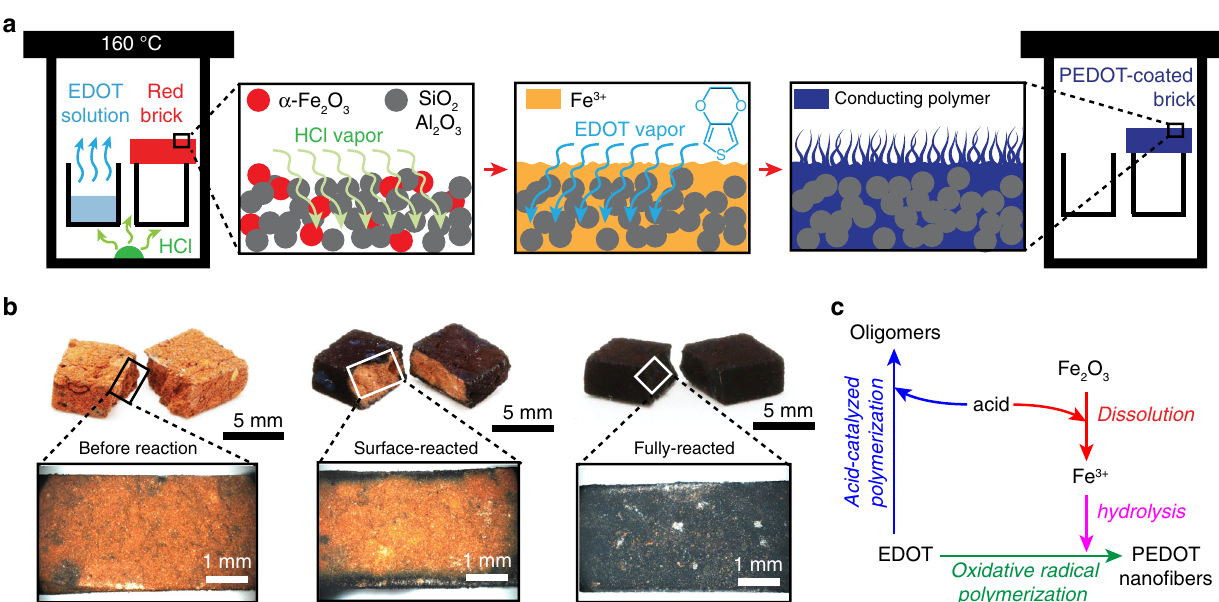
Fig. 1 Deposition of a nano fi brillar PEDOT coating on brick. a In a one-step reaction, a brick ’ s α -Fe 2 O 3 microstructure is partially dissolved by acid vapor to liberate Fe 3 + , promote hydrolysis and precipitation of FeOOH spindles that control oxidative radical polymerization. As previously reported, monomer vapor reacts with partially dissolved FeOOH nuclei resulting in preferential directional growth of high aspect ratio PEDOT nano fi bers 13 . b The thickness of a PEDOT coating is controlled by reaction time and stoichiometry enabling a reaction to generate surface-polymerized PEDOT-coated bricks (core/shell architecture) or fully polymerized bricks (monolithic PEDOT architecture). c A reaction diagram shows the competition between acid-catalyzed polymerization and oxidative radical polymerization mechanisms present in our